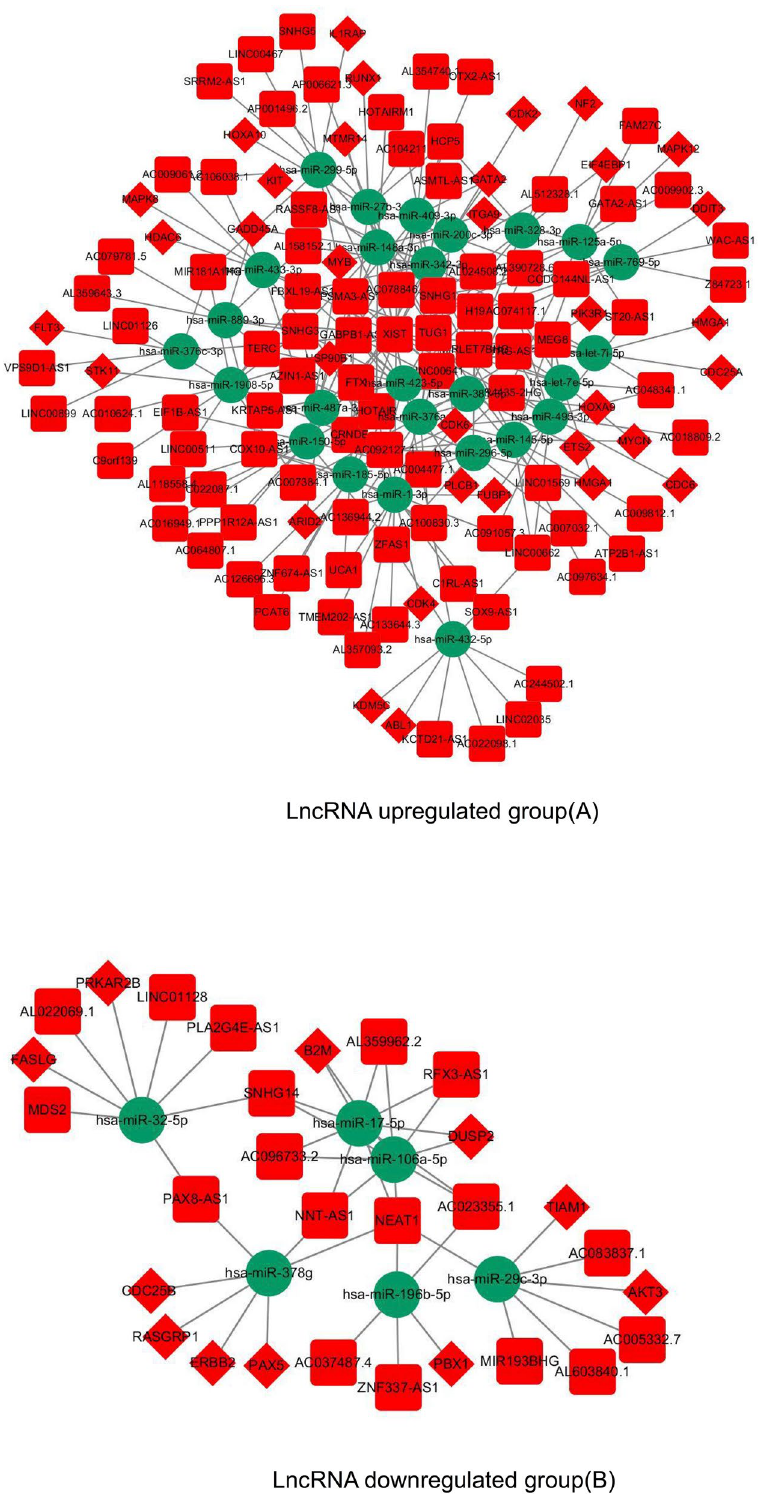
Figure 3. The view of the lncRNA–miRNA–mRNA network in CN-AML. The square represents lncRNAs, the rhombus represents mRNAs, and the circle represents miRNAs. There were 90 lncRNAs, 33mRNAs, 26 miRNAs and 259 edges in the lncRNA upregulated group ( A ), and 18 lncRNAs, 11 mRNAs, 6 miRNAs and 45 edges in the lncRNA downregulated group ( B